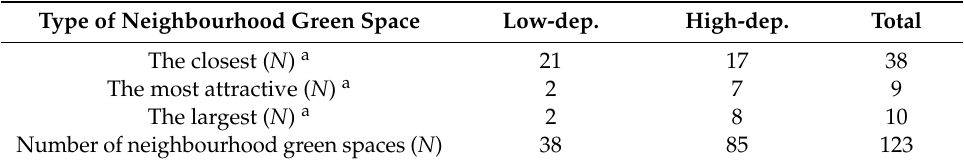
Table 5. Type of neighbourhood green spaces available to participants in low- and high-deprivation areas and in